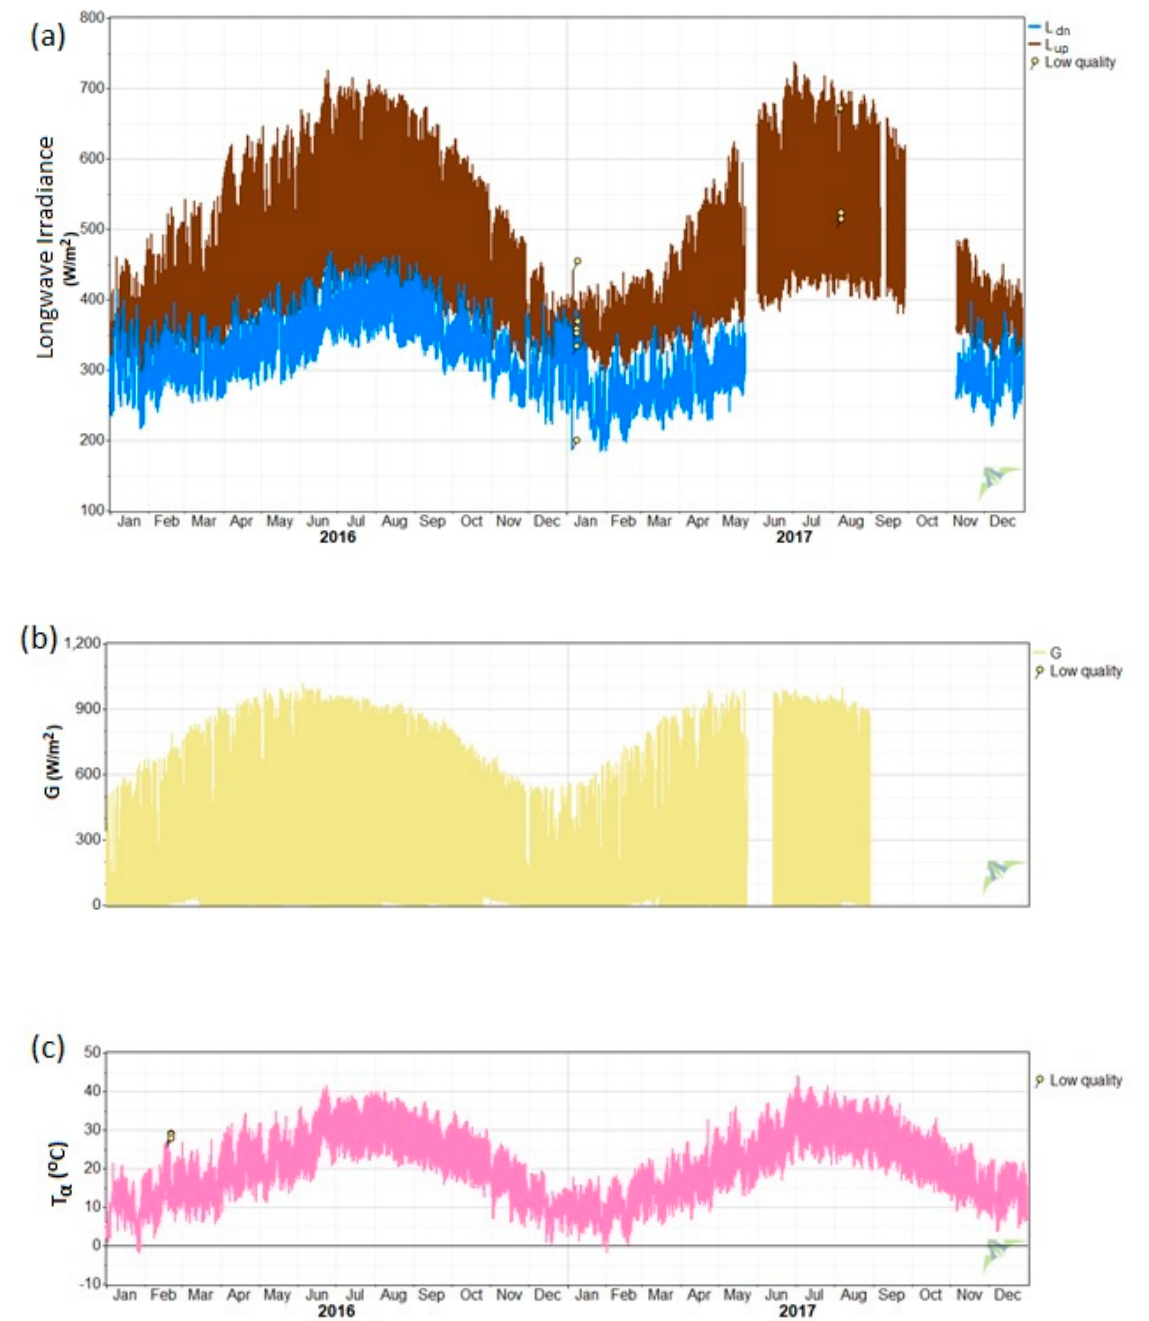
Figure 5. Time series plots of the ( a ) hourly downward and upward longwave irradiances ( b ) hourly global shortwave irradiances and ( c ) hourly air temperatures ( T a ) at screen level at Athalassa.